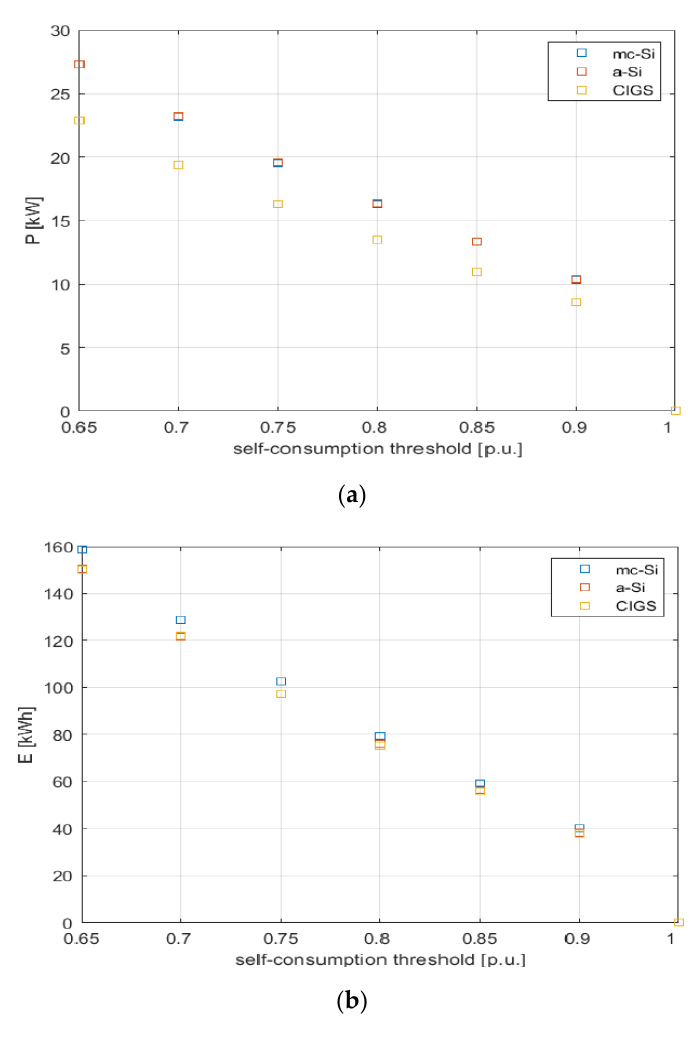
Figure 5. Maximum ( a ) power and ( b ) energy of the different photovoltaic (PV) technologies (a-Si: amorphous silicon; CIGS: copper indium gallium (di)-selenide; mc-Si: multi-crystalline silicon).